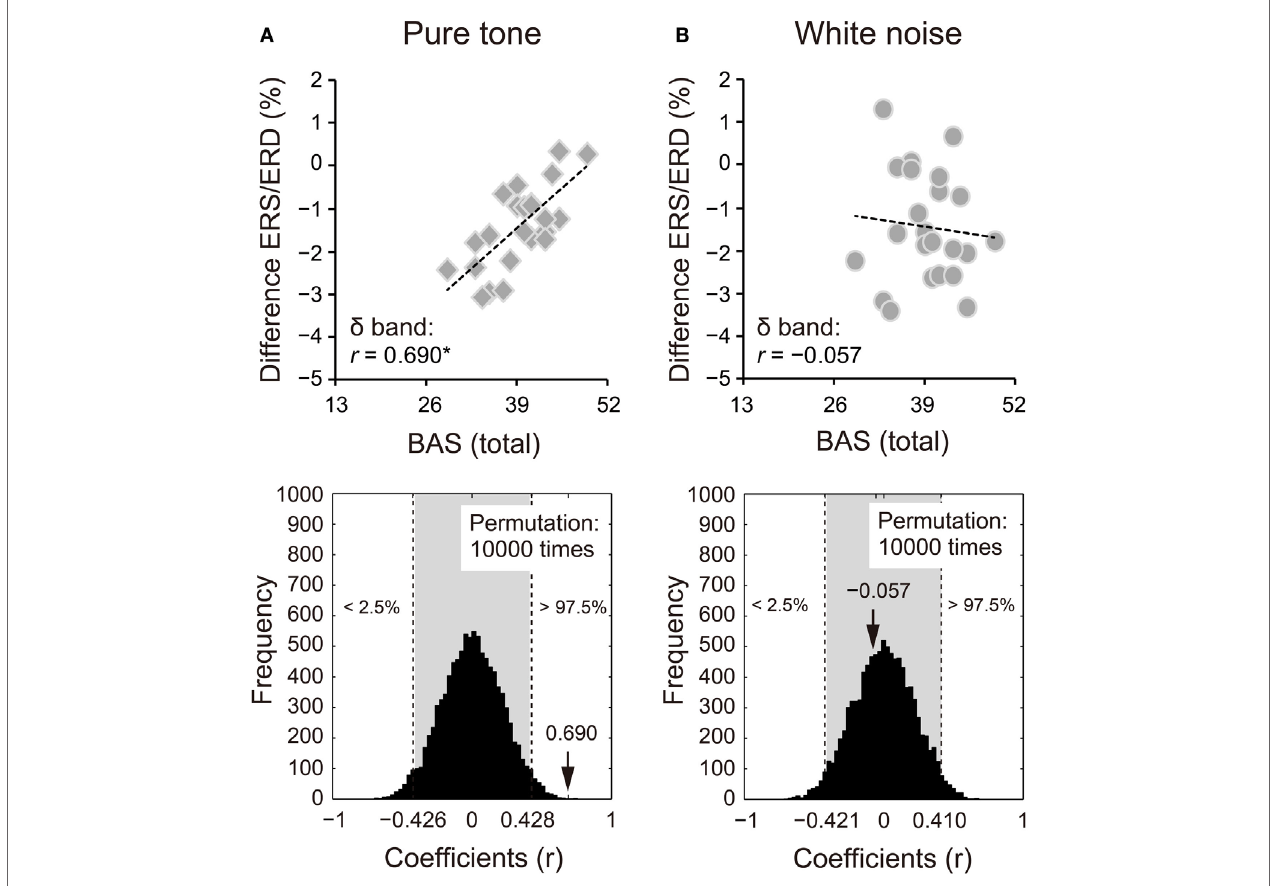
FigUre 5 | Power changes in δ bands (1–4 hz) of the second sounds for (a) pure tone and (B) white noise correlated with total scores of the behavioral activation systems (Bas) components . Power changes of δ bands were calculated by subtraction of event-related desynchronization (ERD) scores for the first stimuli from ERD scores for the second stimuli. That is, more positive scores indicate smaller ERD in S2, compared with S1. Pure tone showed a positive correlation between power change and total BAS scores, suggesting that higher impulsivity yielded smaller ERD for S2. The actual coefficient ( r = 0.690) is outside the 95% confidence interval (light gray area) obtained by permutation analyses [lower diagram in (a)